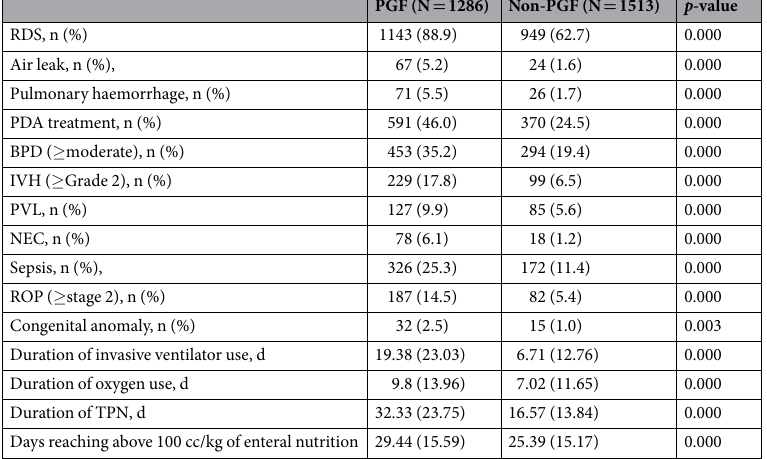
Table 2. Comparisons of morbidities between the postnatal growth failure (PGF) and non-postnatal growth failure (Non-PGF) groups. Data are presented as numbers of patients (%) or mean (SD). PGF, postnatal growth failure; RDS, respiratory distress syndrome; PDA, patent ductus arteriosus; BPD, bronchopulmonary dysplasia; IVH, intraventricular haemorrhage; PVL, periventricular leukomalacia; NEC, necrotizing enterocolitis; ROP, retinopathy of prematurity; TPN, total parenteral